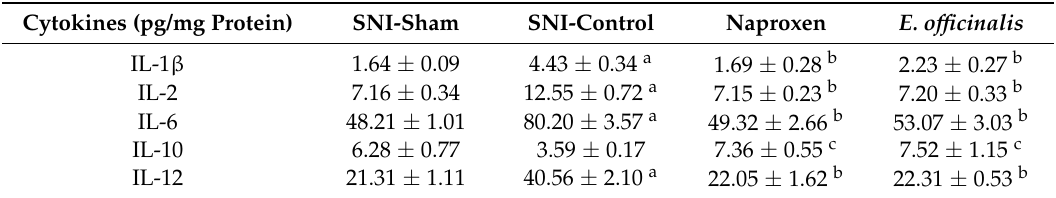
Table 1. Effects of E. officinalis extracts on cytokine expression induced by spared nerve injury (SNI) in the rat dorsal root ganglia (DRG). Cytokines (pg/mg